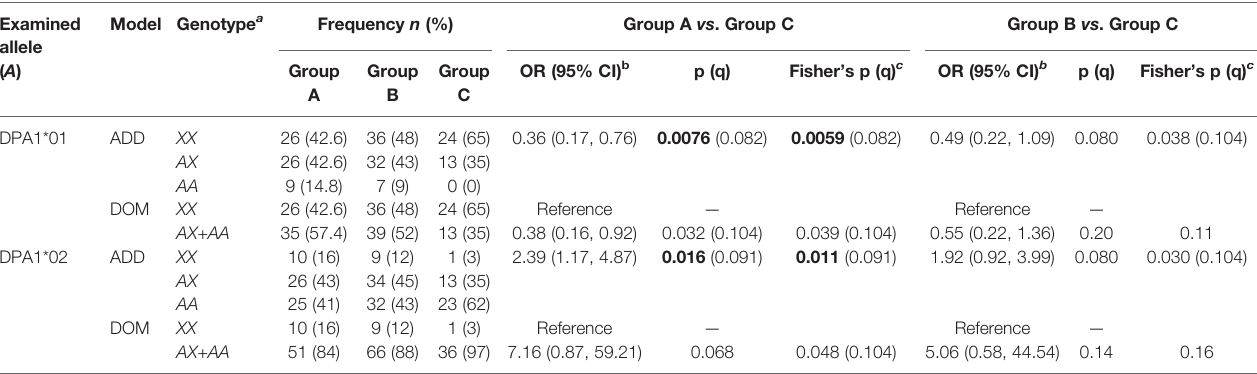
TABLE 2 | Signi fi cant associations of DPA1 alleles with effects of the HBV vaccine. Examined allele